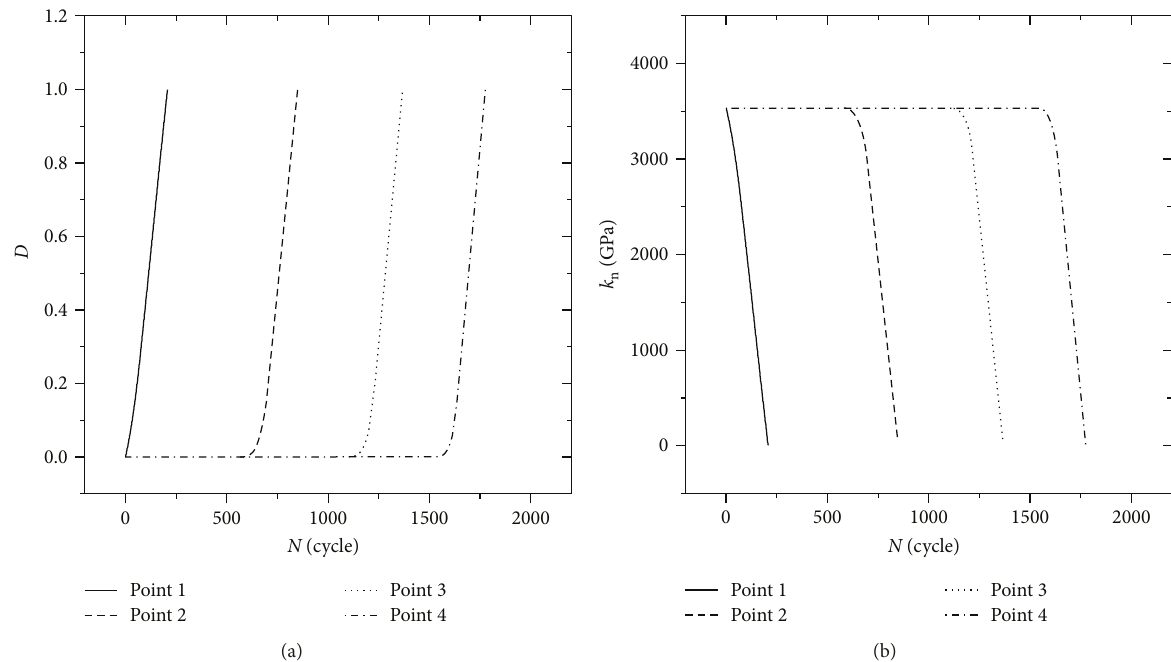
Figure 11: (a) The damage evolution and (b) the cohesive sti ff ness with the number of applied cycles are compared from point 1 to point 4, and the constant loading amplitude is carried out with F max = 24 kN at R = 0 1 , which corresponds to the initial stress intensity factor range Δ K = 76 MPam 1/2 for the CT i